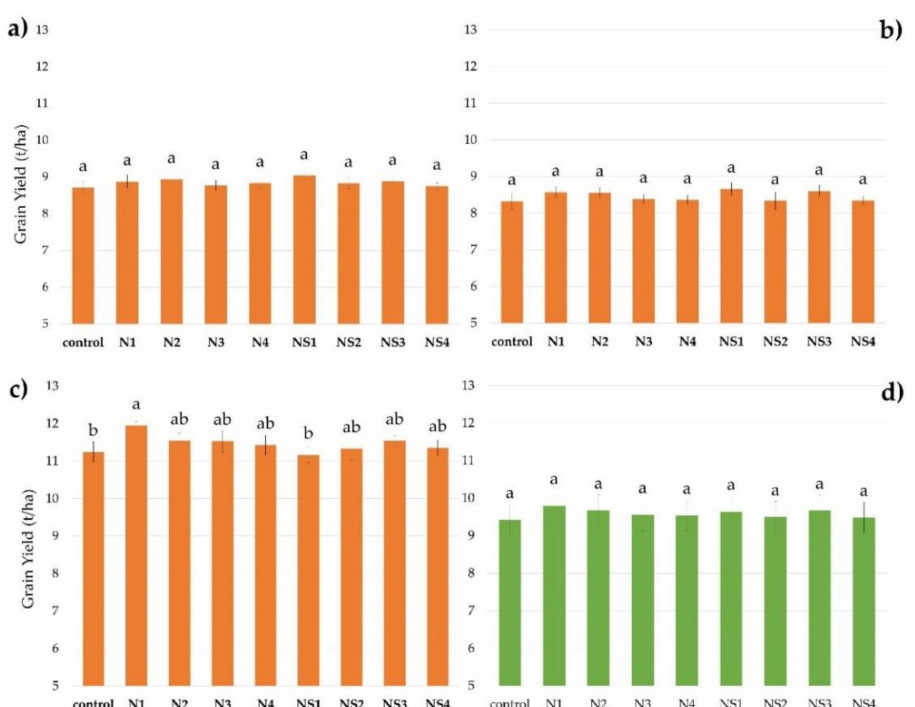
Figure 2. The effect of fertilizer treatments on grain yield (t/ha), ( a ) growing season 1 (2017 − 2018), ( b ) growing season 2 (2018 − 2019), ( c ) growing season 3 (2020 − 2021), ( d ) average yield. The same letters above the columns describe no statistically significant differences between treatments (LSD test). Each growing season was evaluated separately. Standard error (SE) is expressed by error